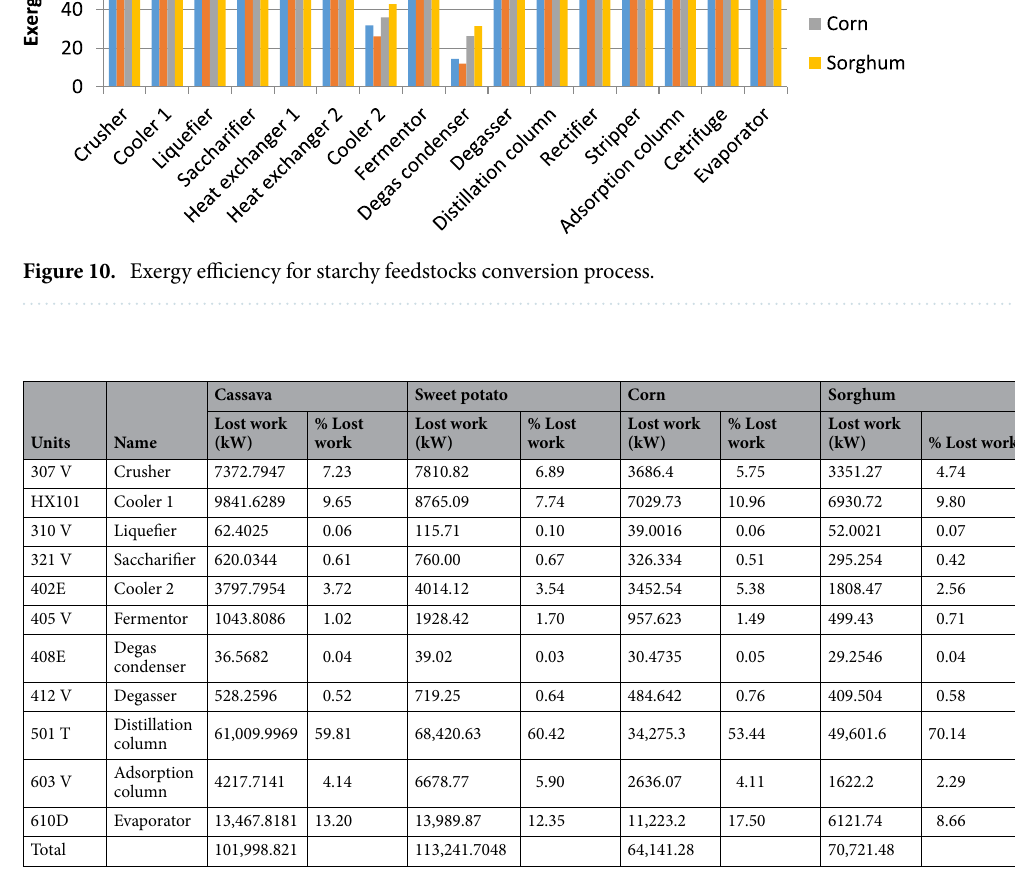
Table 13. Lost work in starchy feedstocks conversion to bioethanol.